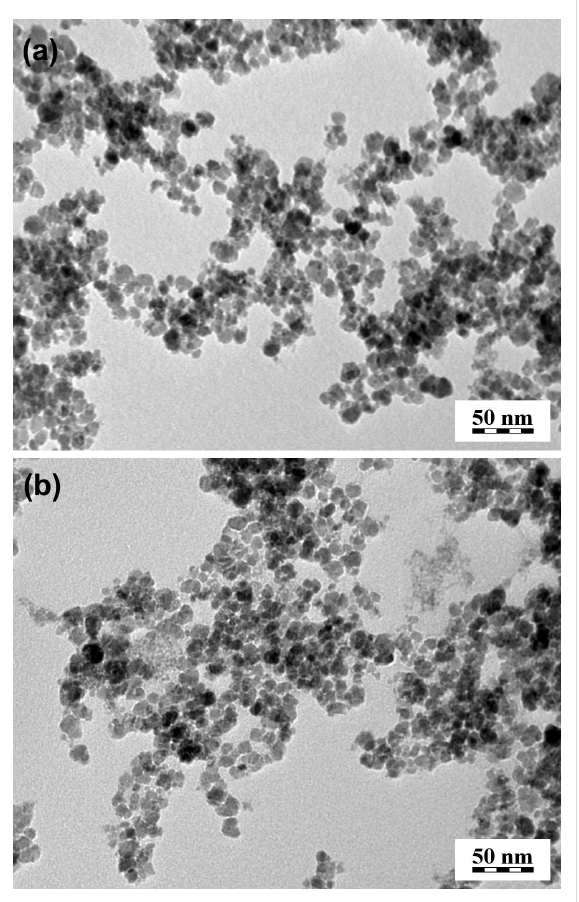
Figure 1: Transmission electron micrographs of (a) neat and (b) D-mannose-coated γ -Fe 2 O 3